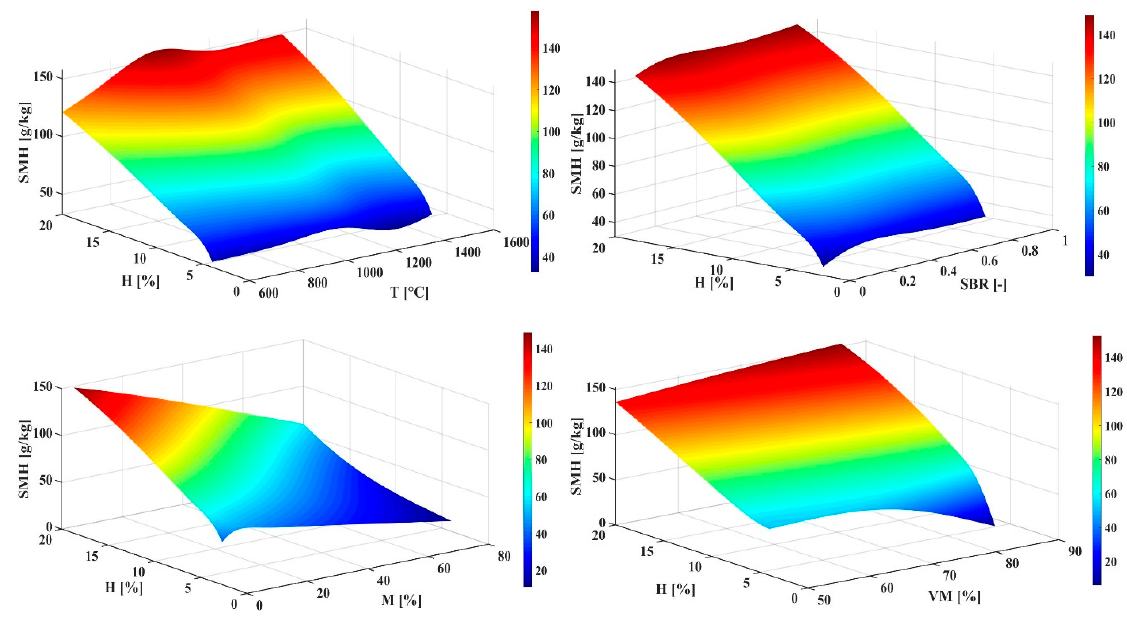
Figure 5. Relative impact (%) of inputs on